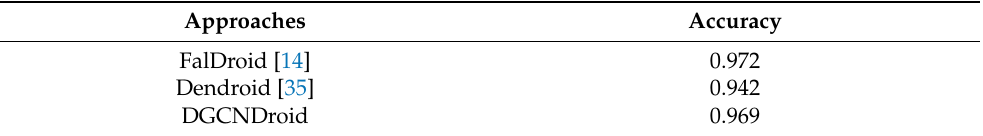
Table 7. Multiple classification results of different